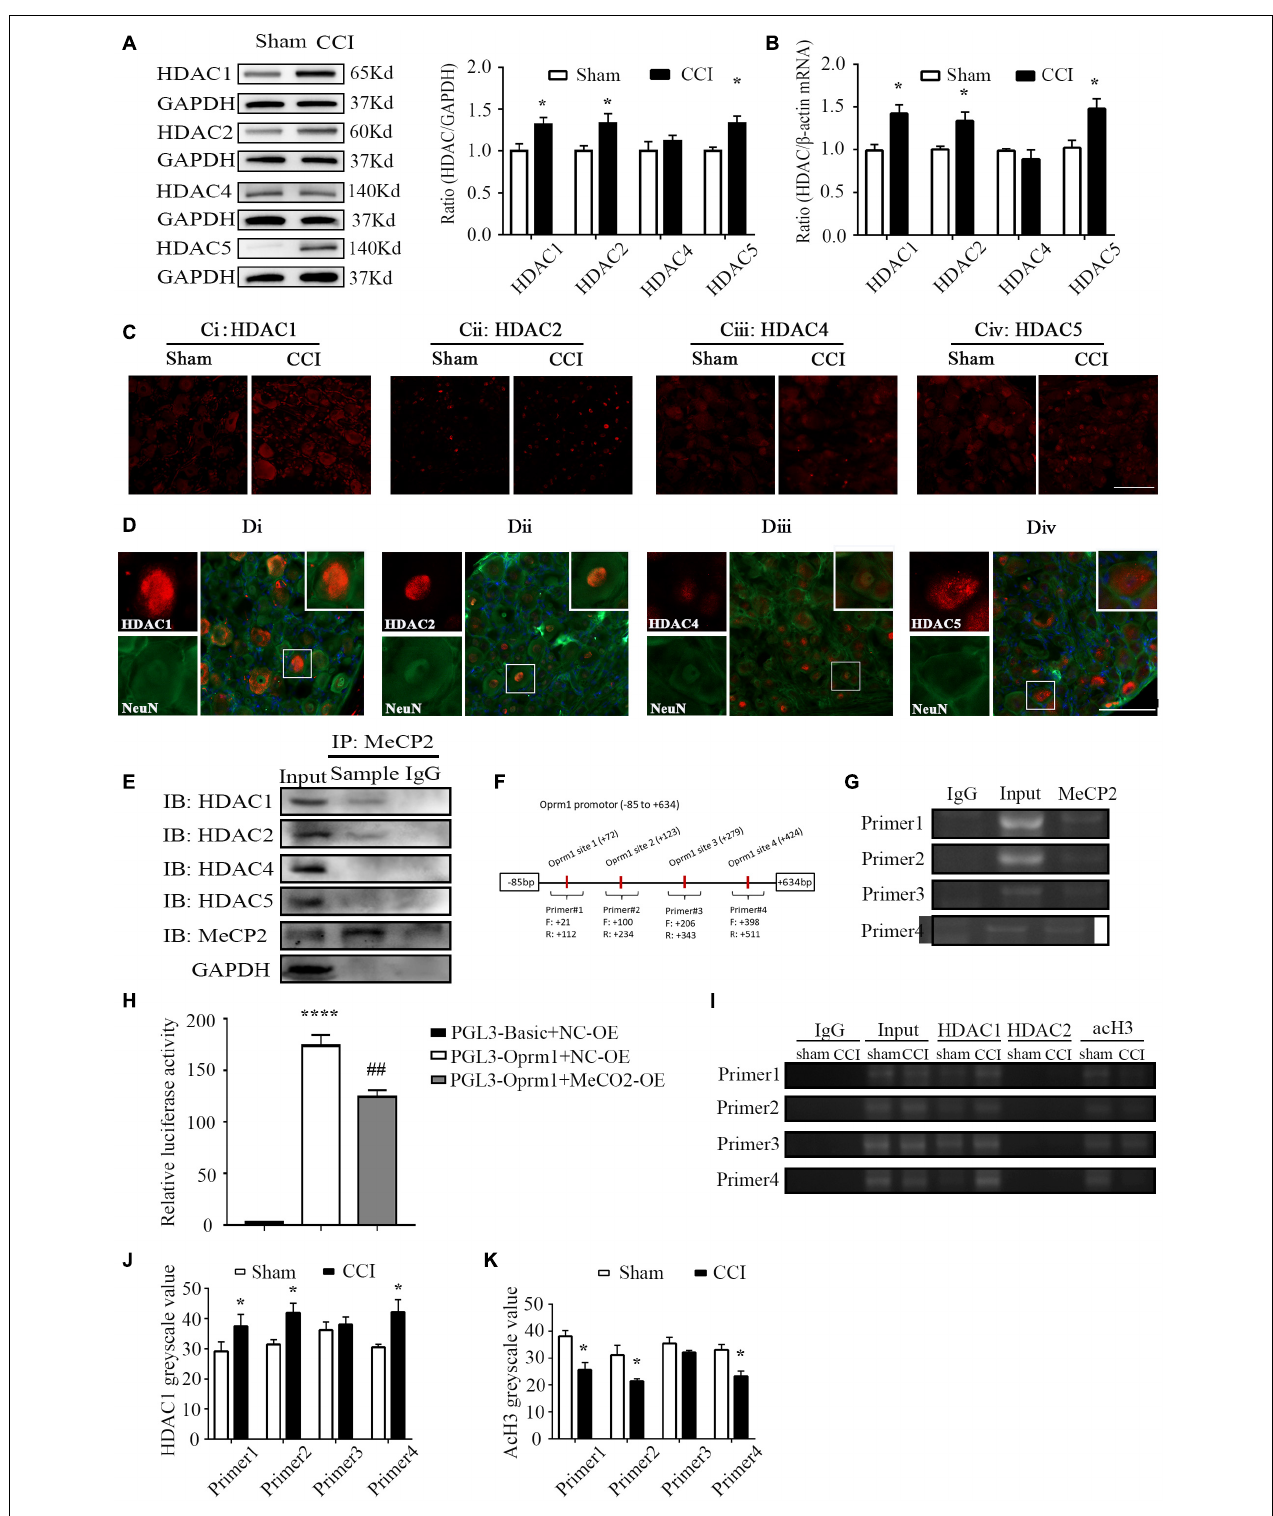
FIGURE 2 | HDAC1 was involved in MOR regulation. (A) Protein levels of HDAC1, –2, –4, and 5 in the ipsilateral L3–5 DRG on day 7 from CCI and sham mice. n = 6 biological repeats (18 mice)/group. * p < 0.05, versus the corresponding sham group by two-tailed unpaired Student’s t -test. (B) RNA levels of HDAC1, –2, –4, and 5 in the ipsilateral L3–5 DRG on day 7 from CCI and sham mice. n = 4 biological repeats (8 mice)/group. * p < 0.05, versus the corresponding sham group by